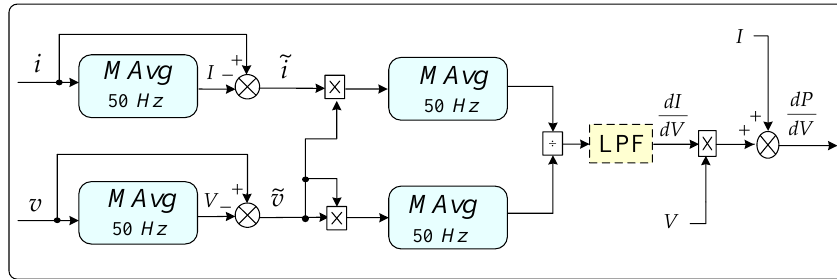
Figure 13. Block diagram of the modified RCC algorithm to estimate dP / dV extending MAvg over T (50 Hz).